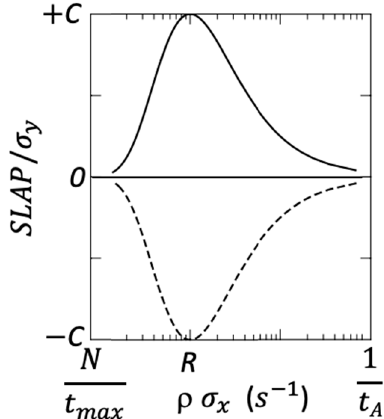
Figure 2. SLAP transformation of the decaying exponentials of Figure 1.